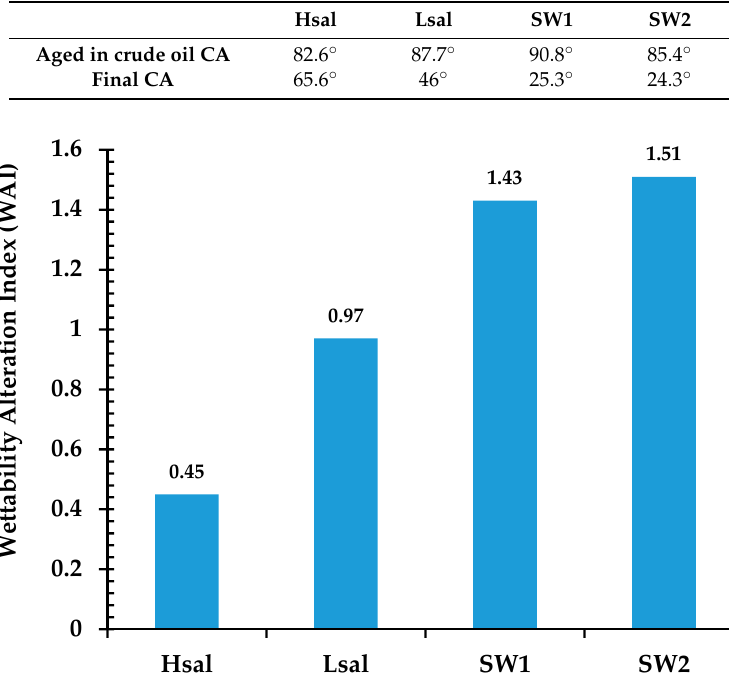
Figure 6. Wettability Alteration Index for Case 3 (neutral wet) calcite surfaces affected by different brines.